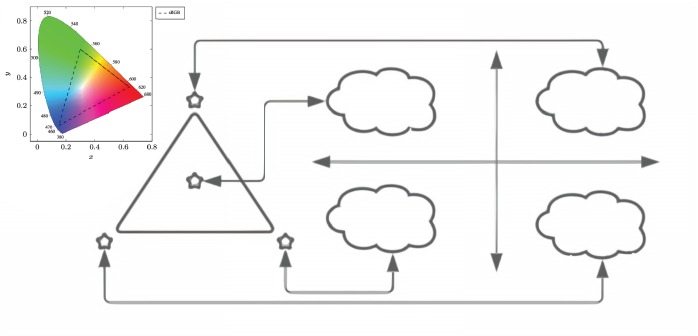
Figure 3. General CSK/QAM assignment.